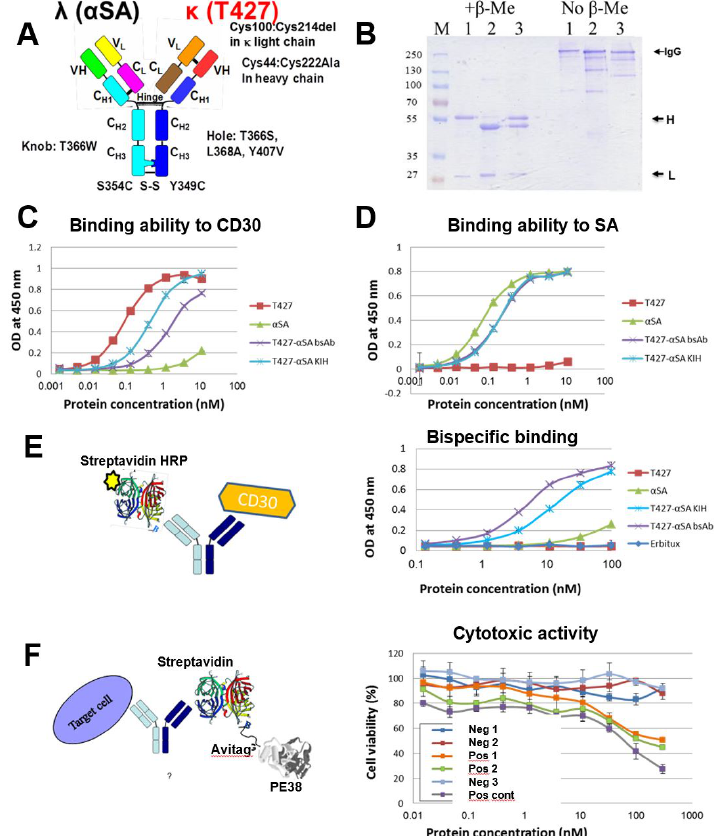
Figure 7. Characterization of refolded T427 (disulfide stabilized)- α SA bi-specific antibody. ( A ) The schematic structure of T427 (disulfide stabilized)- α SA bi-specific antibody. In this model, the T427 antibody (that has a κ light chain) arm was modified to carry disulfide stabilizing mutations (V H C44 and V L C100) while the α SA antibody (that has a λ light chain) arm remained unmodified at the Fab arm interface; ( B ) Sodium dodecyl sulfate polyacrylamide gel electrophoresis (SDS/PAGE) analysis (10% gel) of protein A purified T427 WT (1), α SA WT (2) and T427(disulfide stabilized)- α SA bsAb (3) antibodies; ( C ) Evaluation by ELISA of CD30 binding by the T427 (disulfide stabilized)-anti SA in comparison with WT and KIH (stabilized by KIH at the C H 3-C H 3 interface but unmodified at the Fab arm interface) T427 IgGs; ( D ) Evaluation by ELISA of SA binding by the T427 (disulfide stabilized)- α SA antibody in comparison with WT and KIH IgGs; ( E ) Evaluation by ELISA of simultaneous binding of both CD30 and SA by the T427 (disulfide stabilized)- α SA bsAb. The CD30 antigen was used to coat an ELISA plate, incubated with the evaluated antibodies and binding was detected using horseradish peroxidase (HRP) conjugated streptavidin; ( F ) Evaluation of T427 κ (disulfide stabilized)- α SA bispecificity by recruiting an effector function (cytotoxic activity) to target cells. Neg 1 : T427 mAb mixed with α SA mAb and with SA and biotinylated Avitag-PE38; Neg 2 : α SA mAb and with SA and biotinylated Avitag-PE38; Pos 1 :T427/ α SA bsAb with SA and biotinylated Avitag-PE38; Pos 2 : T427/ α SA bsAB (KIH only) with SA and biotinylated Avitag-PE38; Neg 3 : SA and biotinylated Avitag-PE38 (no antibody present); Pos cont : A T427 IgG-PE38 fusion protein as positive control. Cytotoxicity was evaluated using an MTT assay. The evaluated antibodies were mixed with a streptavidin-PE38 complex and added to A431/CD30 cell line. Streptavidin-PE38 complex served as a control for non-specific toxic effect. T427-di-PE38 immunotoxin [17] served as a positive